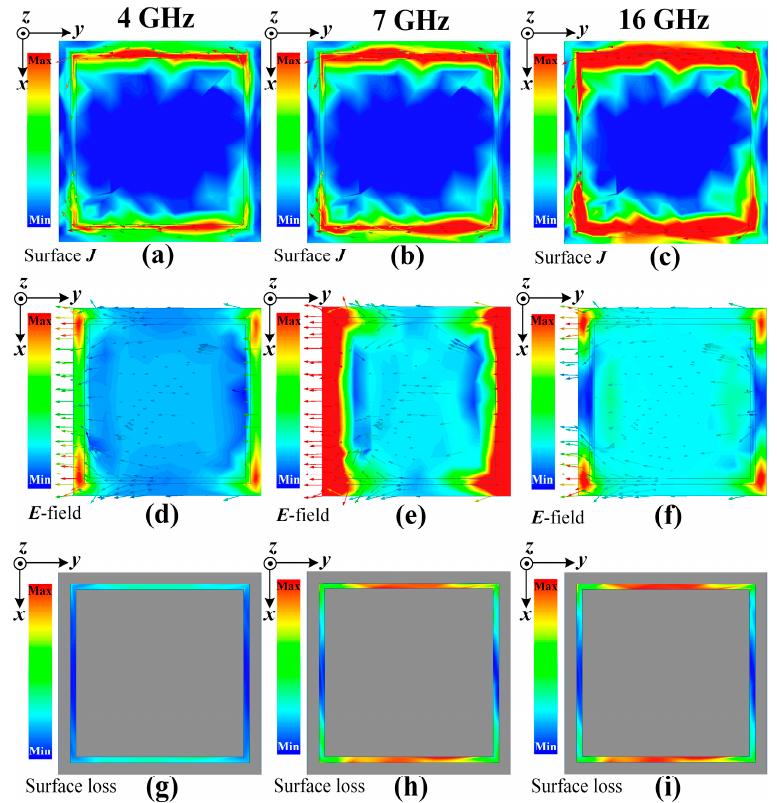
Figure 8. The ( a – c ) surface current density J distributions; ( d – f ) E -field distributions and ( g – i ) surface loss density distributions of the designed OTMMA’s unit cell at 4, 7 and 16 GHz, respectively, at normal incident plane